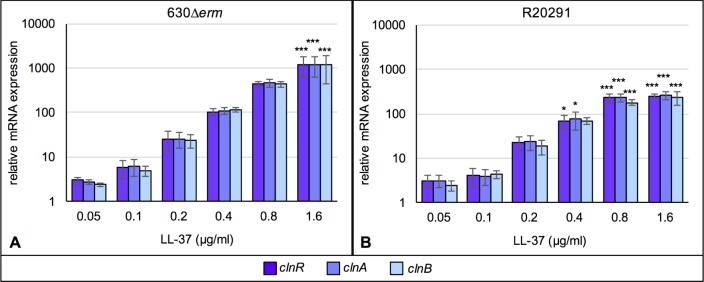
Expression of CD630_16170-CD630_16190 is induced by LL-37 in a dose-dependent manner.Active cultures of A) 630Δerm and B) R20291 were grown in BHIS or BHIS with 0.05, 0.1, 0.2, 0.4, 0.8 or 1.6 μg/ml LL-37. Samples were harvested, cDNA generated, and qRT-PCR performed as described in Methods. mRNA levels are normalized to expression levels in BHIS alone. Bars represent the mean and standard deviation for at least three biological replicates. Expression levels of each gene were analyzed by one-way ANOVA and Dunnett’s multiple comparisons test, comparing to expression without LL-37. Adjusted p values indicated by * ≤ 0.05, ** ≤ 0.01, *** ≤ 0.001.